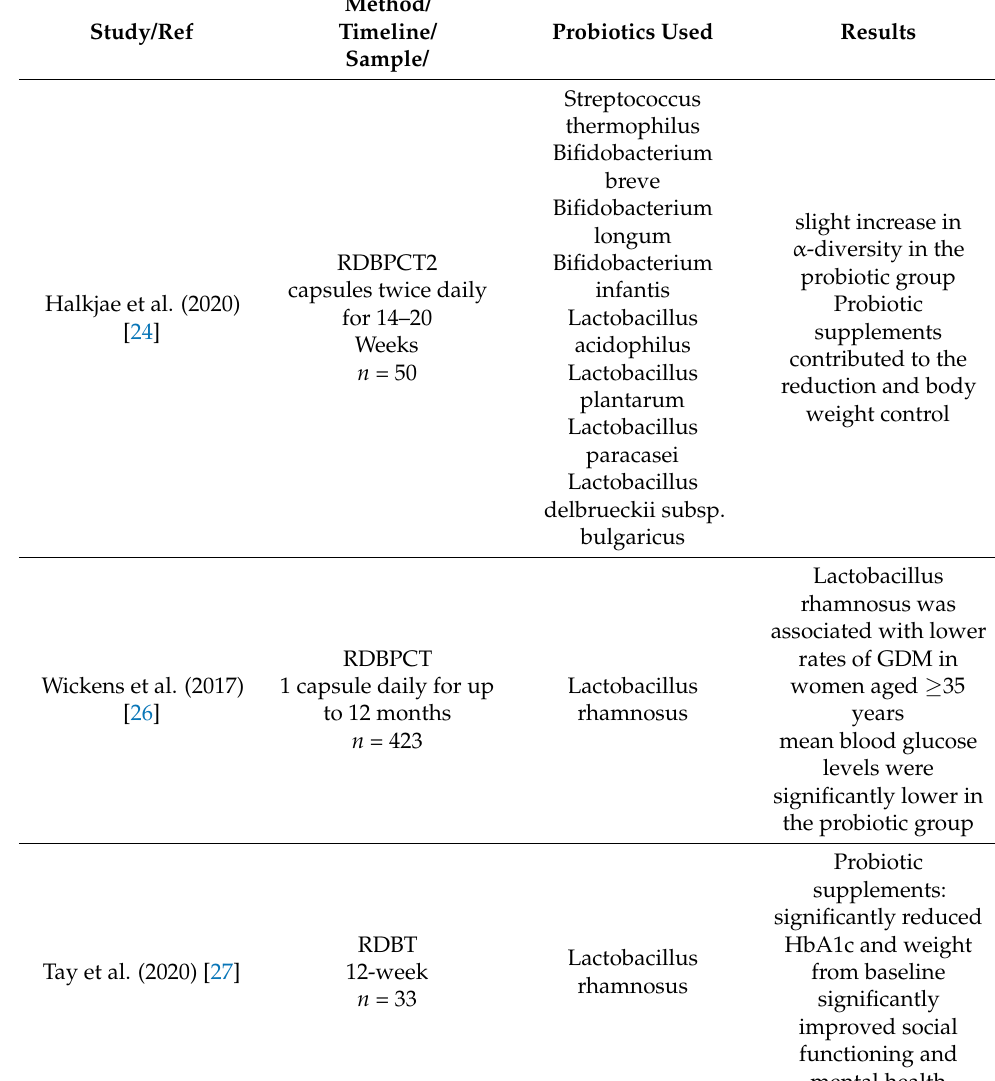
Table 1. Clinical trials of probiotics on gestational diabetes